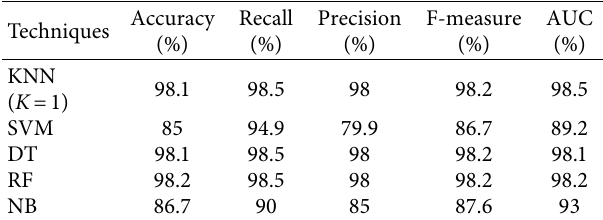
Table 9: Classification performance of applying boosting technique to selected features by LAD.